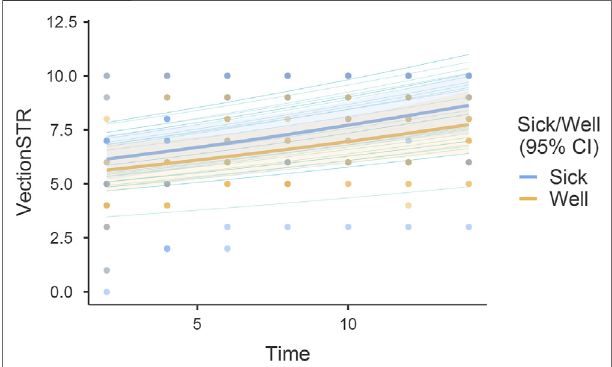
FIGURE8| Showsvectionstrengthratings(VectionSTR)asafunctionof time in trial (Time) and participant Sick/Well grouping.